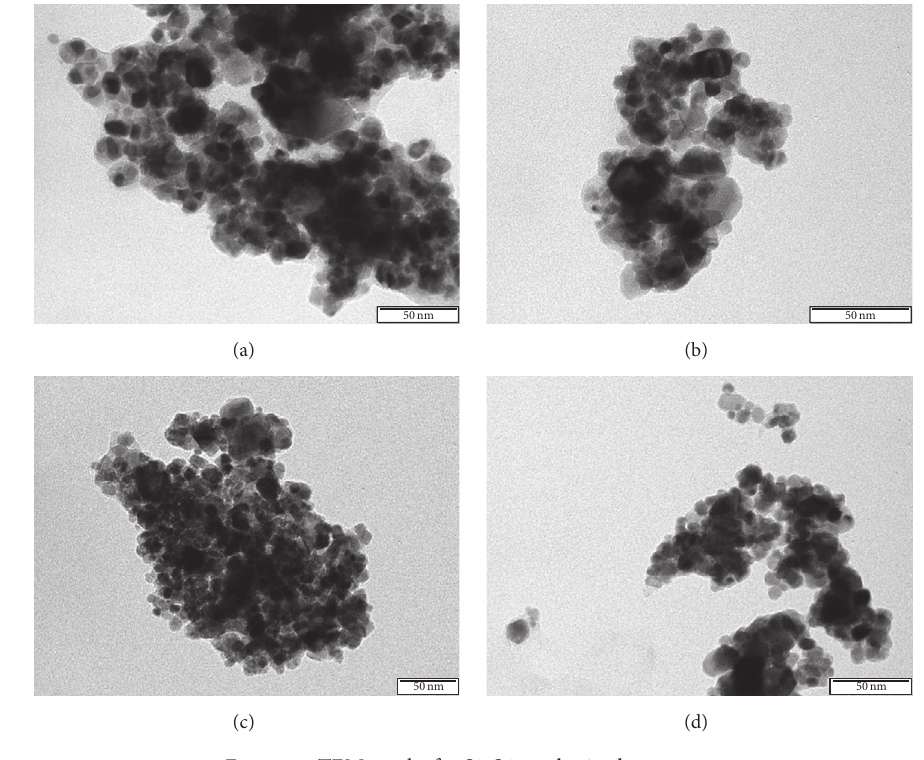
Figure 7: TEM results for S1–S4 synthesized structures.